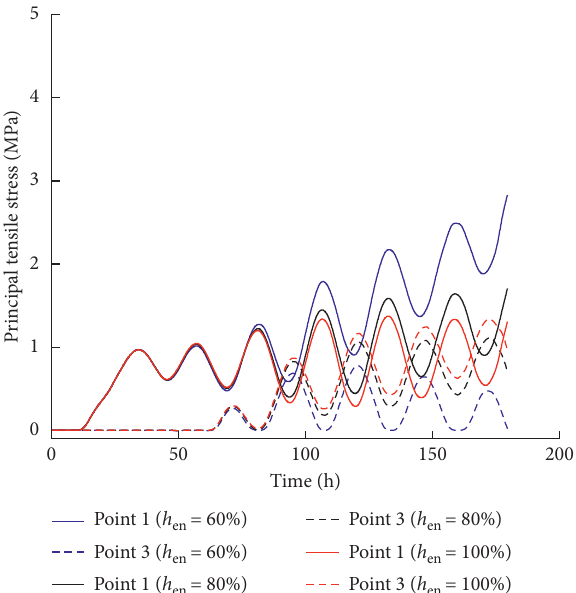
Figure 18: Comparison of time-dependent principal tensile stress distribution at points 1 and 3 (regardless of creep).